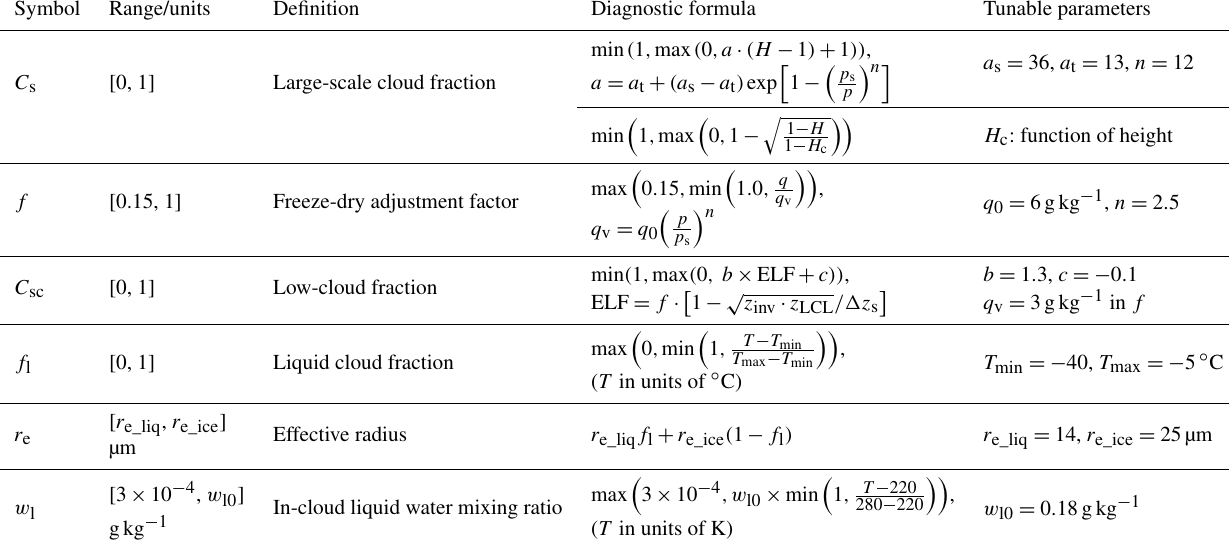
Table 1. Summary of the simple diagnostic cloud scheme. Note that two options are provided for the large-scale cloud fraction ( C s ). Symbol